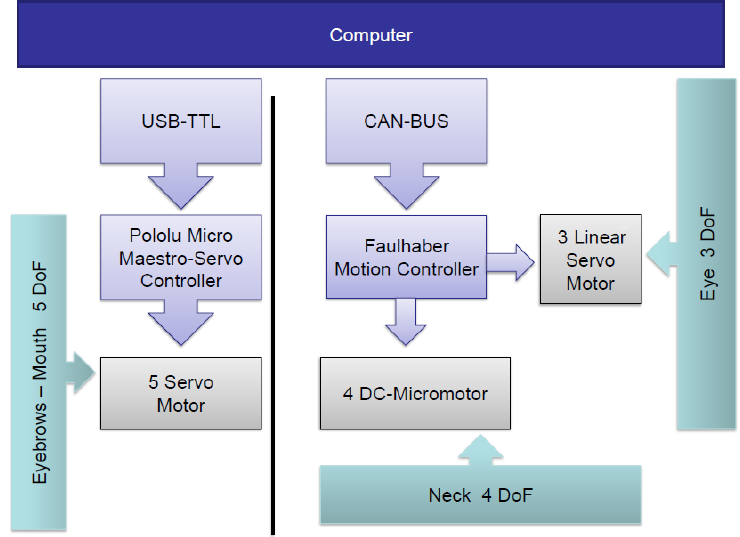
Figure 6. Architecture of the motor